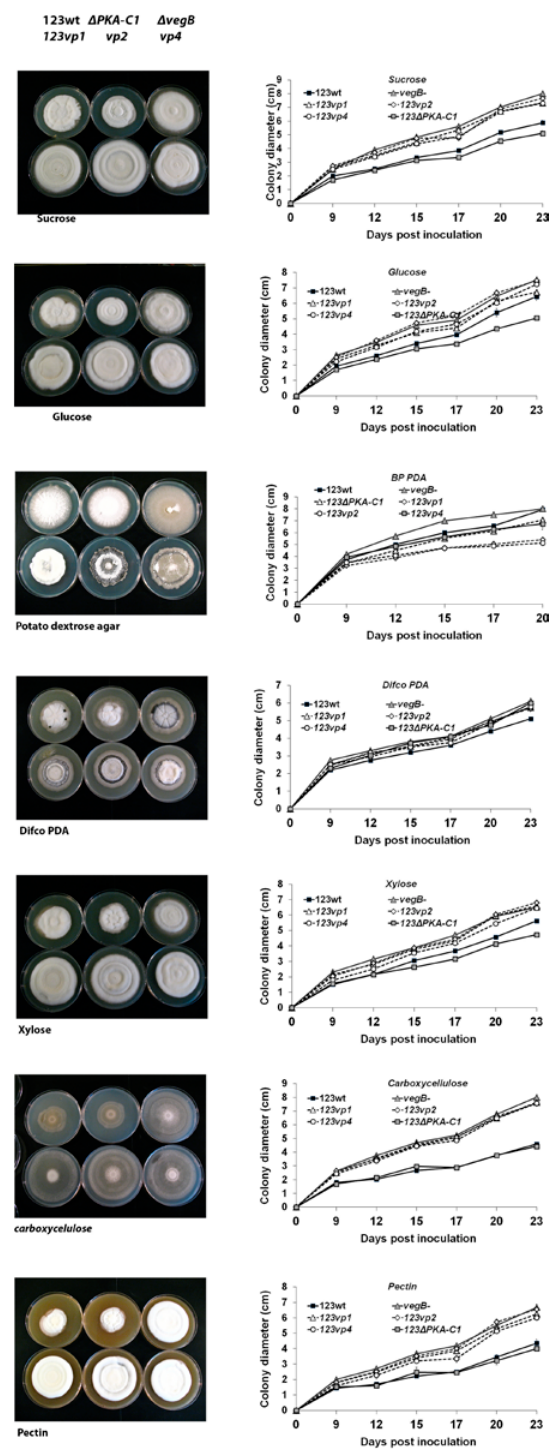
Figure 2. Radial growth of Verticillium dahliae wild type (123wt- r2), mutant veg B - and double disruptants 123Δ VP1 , 123Δ VP2 and 123Δ VP4 on different carbon sources. Left: Images of fungal colo- nies on carbon sources after 23 d of growth. Right: Graphs present- ing radial growth of the strains at specific time